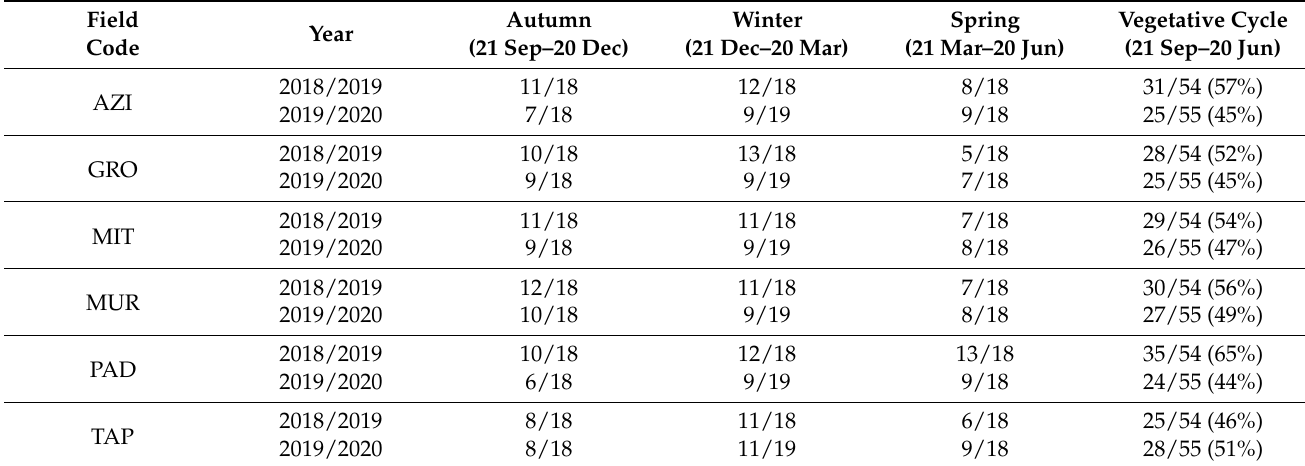
Table 1. Number of Sentinel-2 images without cloud effect in relation to the total number of satellite images available during the dryland pastures vegetative cycles of 2018/2019 and 2019/2020, by season (autumn: 21 September–20 December; winter: 21 December–20 March; and spring: 21 March–20 June) and throughout the vegetative cycle (21 September–20